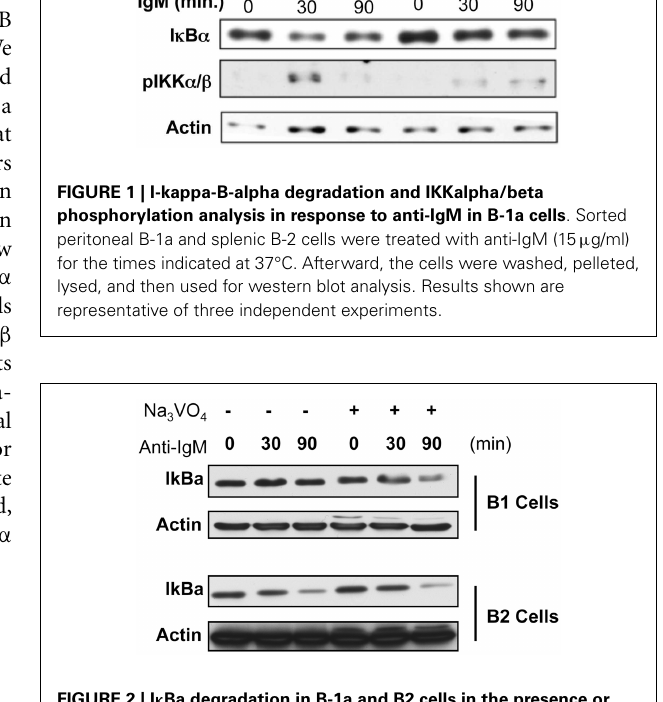
FIGURE 2 | I κ Ba degradation in B-1a and B2 cells in the presence or absence of phosphatase inhibition . Sorted B-1a and B-2 cells were pre-treated for 1h with cycloheximide (50 µ M). Afterward, cells were either treated with or without anit-IgM (15 µ g/ml) for 30 or 90min, as indicated, or cells were cultured with 2mM sodium orthovanadate (Na 3 VO 4 ) for 15min and then treated with anti-IgM for 30or 90min. Cells were collected, supernatants discarded, and pellets frozen at − 20°C until lysed in NP-40 lysis buffer and used for western blot analysis of I κ B α . Results shown are representative of two independent